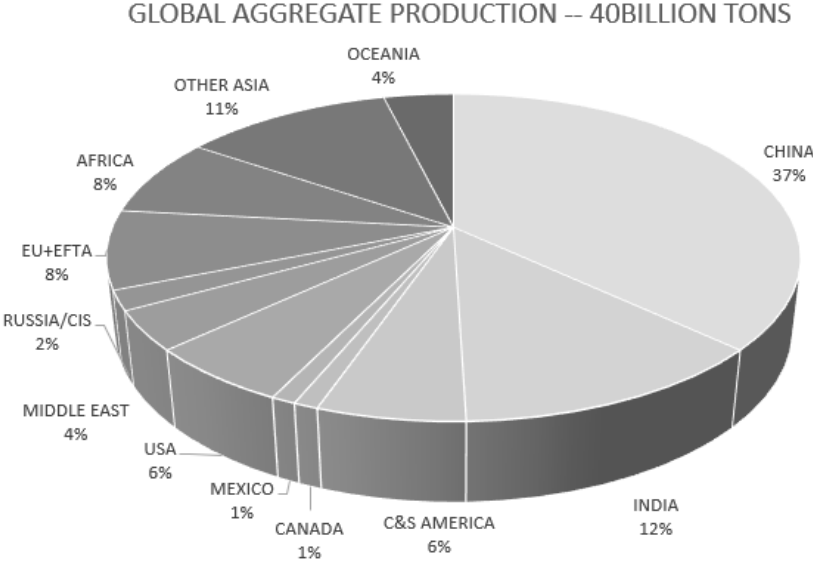
Figure 1. Global aggregate production in 2014 [1].